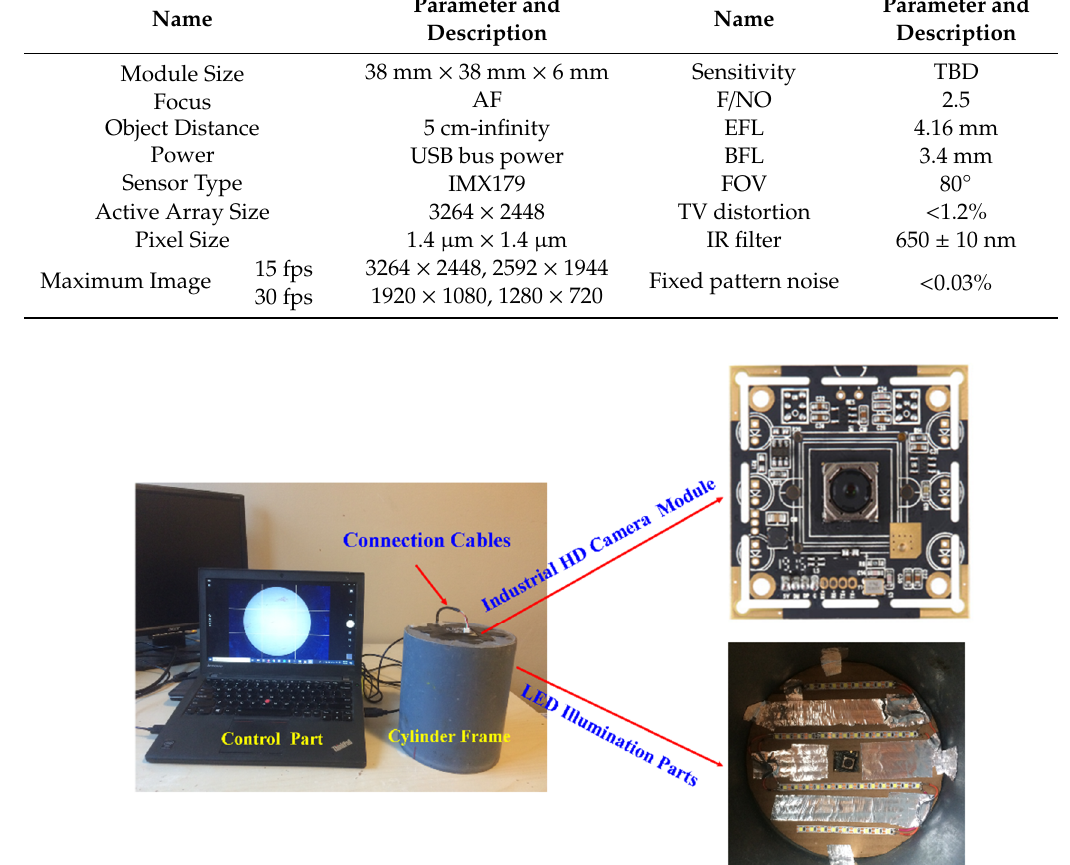
Figure 3. Industrial HD macro photography image capturing system.